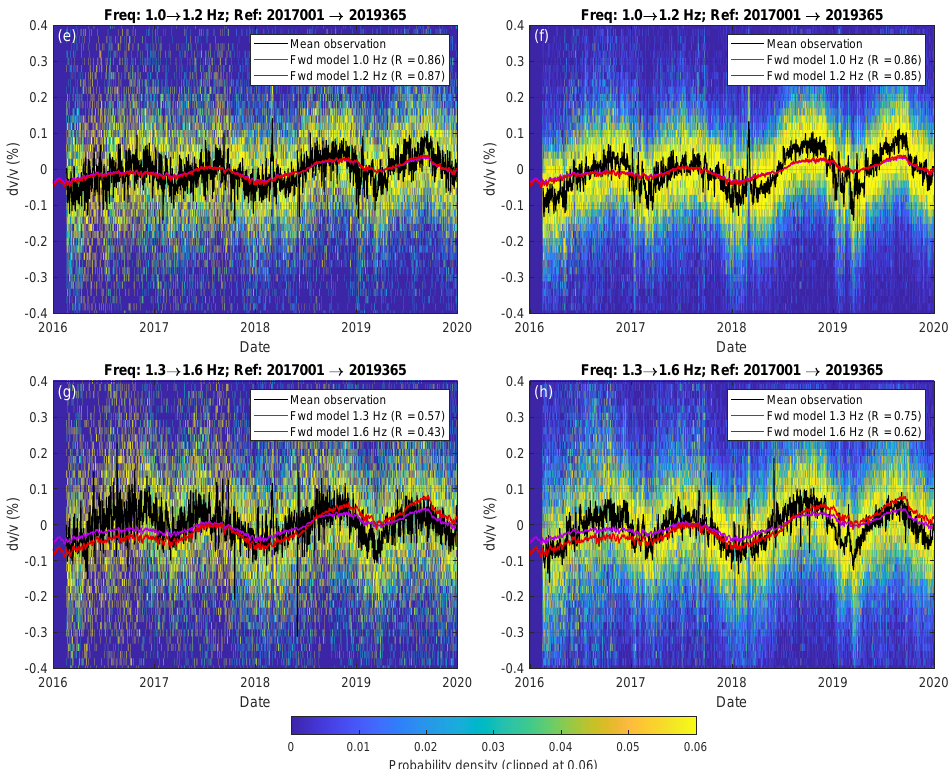
Figure 12. Time–lapse seismic velocity change retrieved from seismic ambient noise within the indicated frequency bandwidths, using the coda of the cross-coherence of vertical (left; ZZ) and horizontal (right; RR, RT, TR, TT) components between 78 receiver combinations. The background colors show the probability distribution of 78 (left) and 312 (right) estimates from dark blue (low probability) to yellow (high probability), while the black line shows the average velocity change. The purple and red lines show the results of the independent forward model for velocity change of Rayleigh waves ( a , c , e , f , g , h ) and the Voigt average ( b , d ) as in Figure 9. The match between the low- frequency trends of the modeled and the observed velocity change was quantified with a Pearson correlation after a low-pass filter was applied with a cut-off period of 60 days. The correlation coefficient R is shown in the